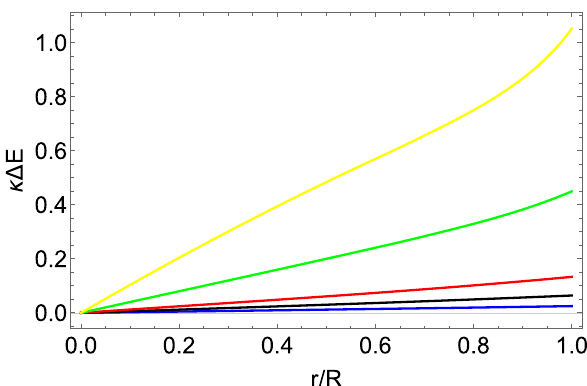
Fig. 9 Δ E for u = 0 . 1 (blue line), u = 0 . 15 (black line), u = 0 . 2 (red line), u = 0 . 3 (green line), u = 0 . 37 (yellow line) and (cid:13) = ρ s = 3